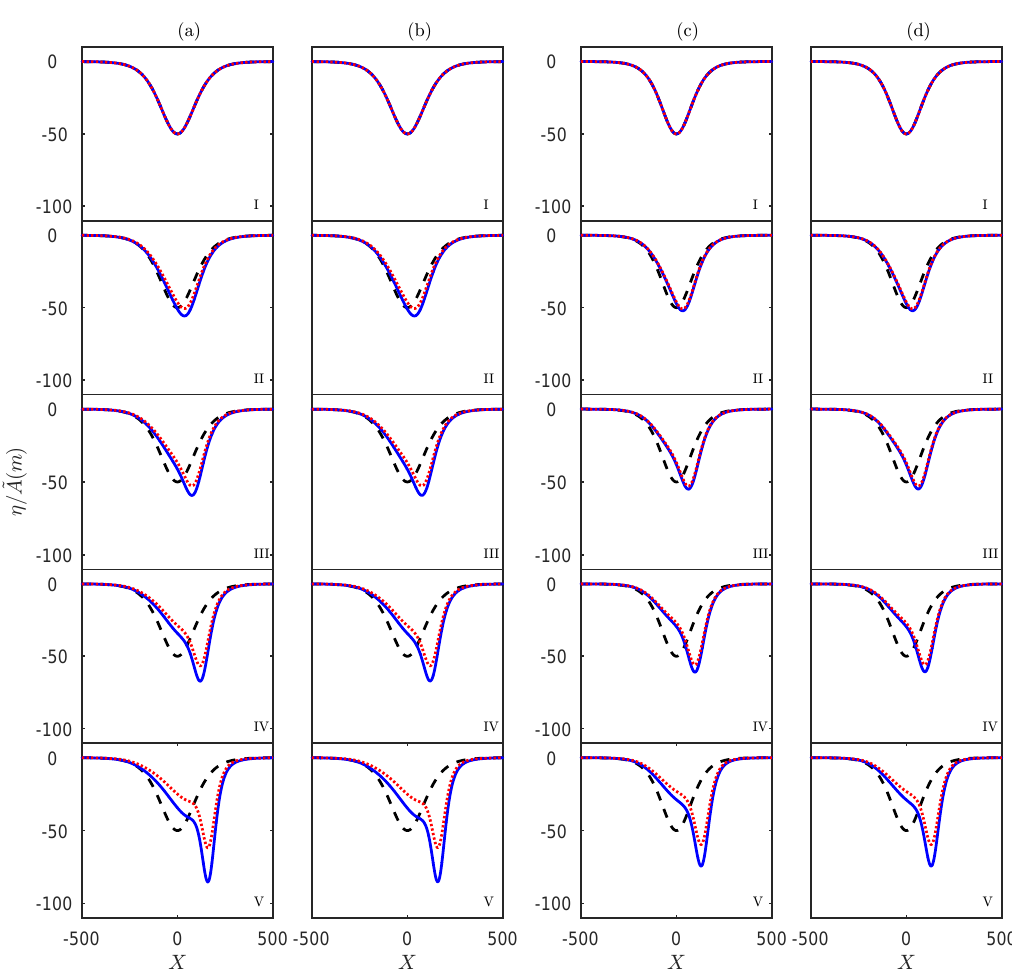
Figure 4. A numerical simulation of the vKdV Equation (5) for the Western Portugal case for summer ( a , b ) and winter ( c , d ) conditions, with u 0 = 0 ( a , c ) or u 0 (cid:54) = 0 ( b , d ), respectively. The initial condition is the solitary wave (black, dash), the numerical solution is ˜ A (red, dot) and the physical solution is η (blue, solid). From top to bottom, the distances from the initial point are (I) 0 km, (II) 110 km, (III) 220 km, (IV) 330 km, (V) 440 km,